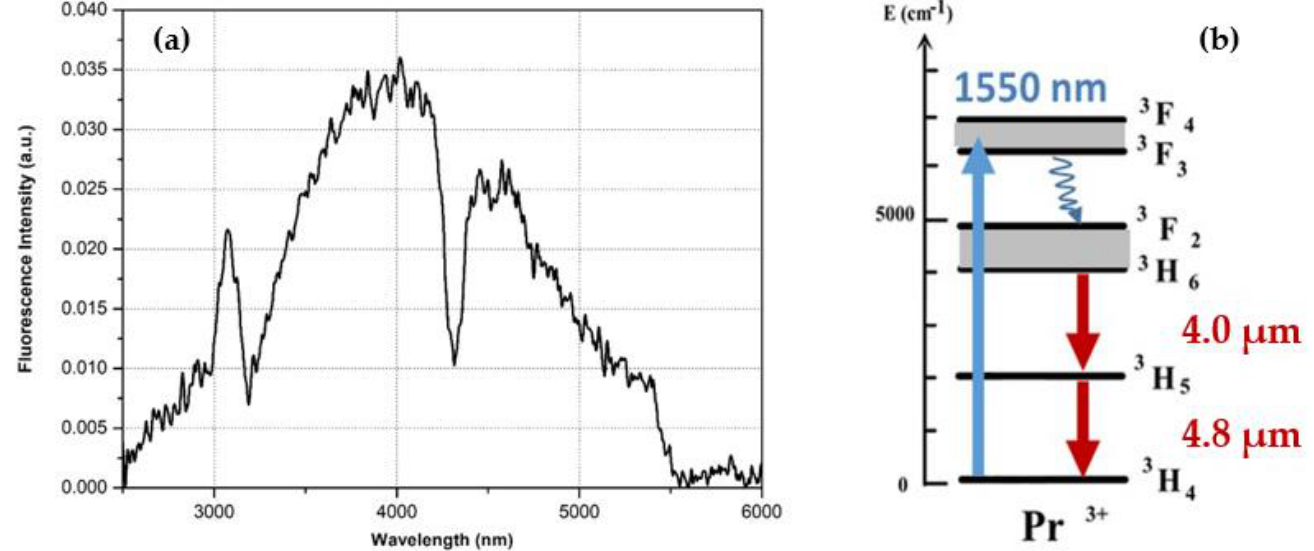
Figure 5. ( a ) Fluorescence intensity of the core of the double index fiber glasses ([GeS 2 ] 0.80 - [Ga 2 S 3 ] 0.20 ) 90 -(CsCl) 10 and ([GeS 2 ] 0.80 -[Ga 2 S 3 ] 0.20 ) 90 -(CdI 2 ) 10 :1000 ppmw Pr 3+ ) as a function of the wavelength; ( b ) energy level diagram of ion Pr 3+ .